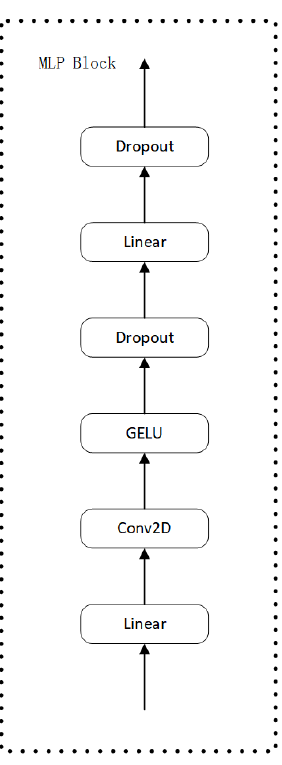
Figure 4. The details of the MLP block.